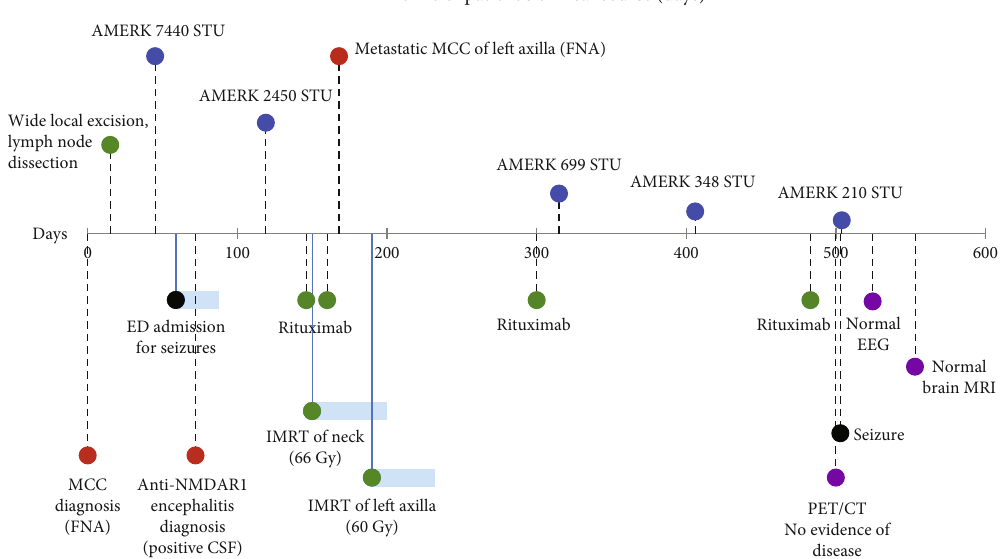
Figure 3: Timeline of patient ’ s clinical course highlighting surgical excision, radiation, and MCPyV antibody panel AMERK results for the treatment and management of his MCC, as well as rituximab infusions for his paraneoplastic autoimmune encephalitis. Day 0 is set to his initial MCC diagnosis. Red: diagnoses; blue: AMERK titers; green: treatment interventions for MCC and encephalitis, including wide local excision, IMRT, and rituximab infusions (1 g); black: seizures; purple: latest follow-up scans and